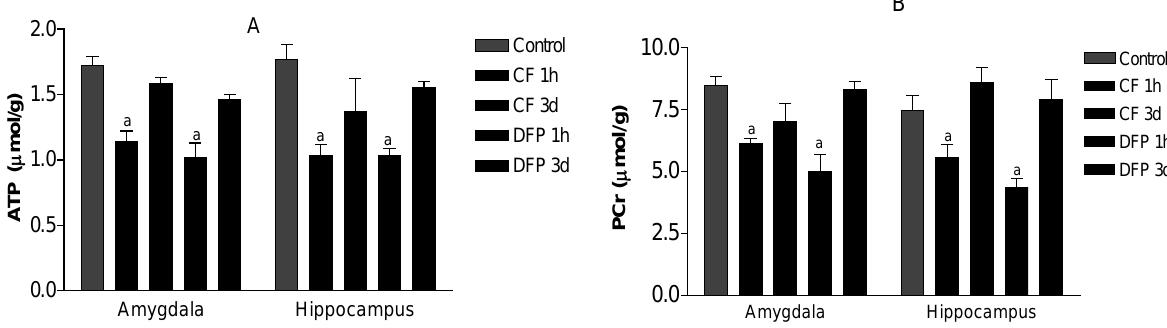
FIGURE 1. Levels of high-energy phosphates, (A) ATP and (B) PCr in amygdala and hippocampus of rats intoxicated with an acute dose of CF (1.25 mg/kg, s.c.) or DFP (1.25 mg/kg, s.c.). Rats were sacrificed 1 h or 3 days (3d) after CF or DFP injection. Values of ATP and PCr are presented as mean ± SEM (n = 4–6). a Significant difference between values from control rats and DFP- or CF-treated rats ( p <